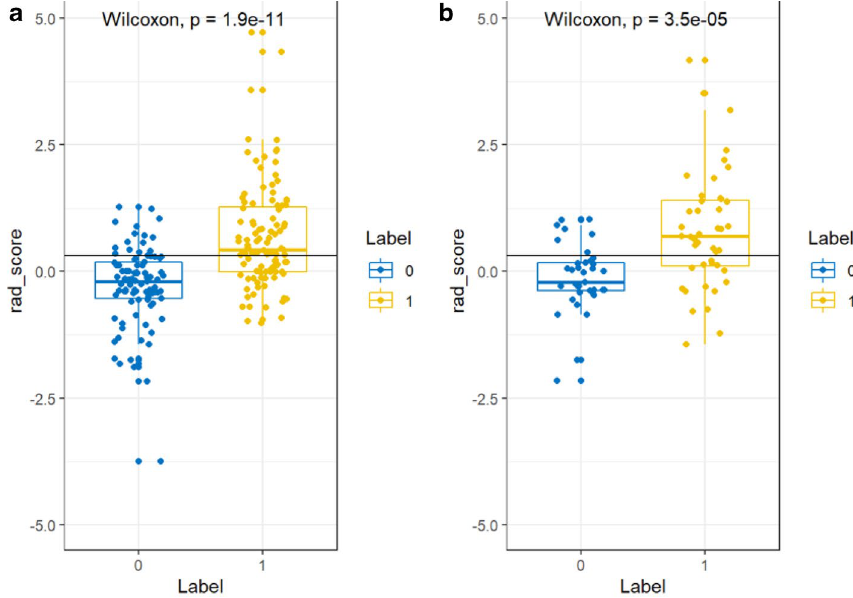
Figure 3. Radiomics score distribution of the 292 patients is shown for ( a ) the training group and ( b ) the validation group. The low-risk group is colored blue (0), and the high-risk group is colored yellow (1).